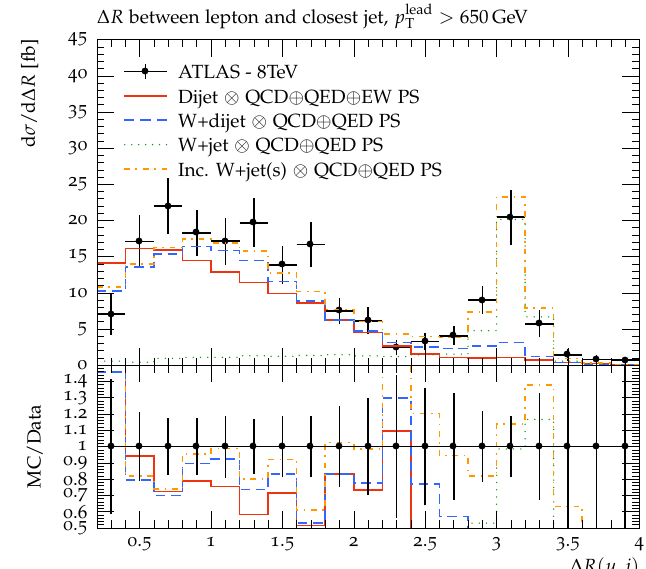
Figure 15. The angular distribution of W bosons accompanied with high transverse momentum √ jets at s = 8 TeV. The data is from ATLAS [32], showing the angular distribution of the muon and the closest jet with p t > 650 GeV . The notation of the plot is the same as in figure